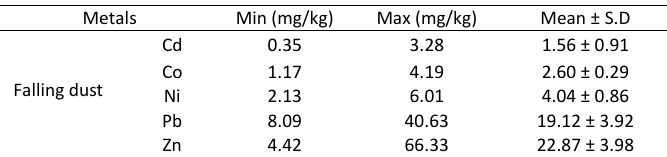
Table 1. Descriptive statistics of the concentration of heavy metals in falling